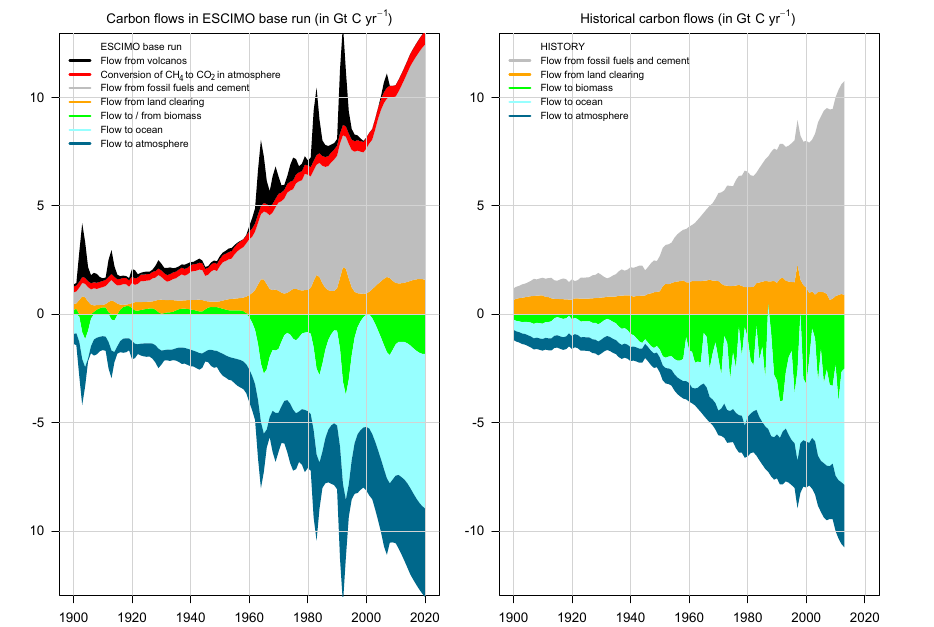
Figure 6. Carbon flows (in GtCyr − 1 ) in the ESCIMO base run compared with observed carbon flows. World 1900 to 2015.